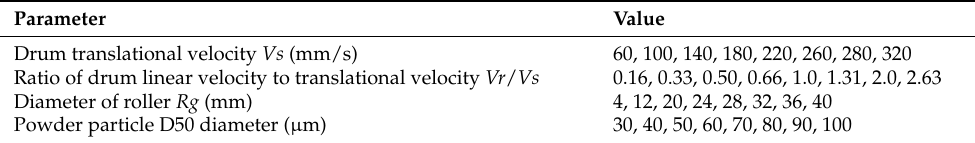
Table 2. Working parameters of numerical simulation of powder laying process.